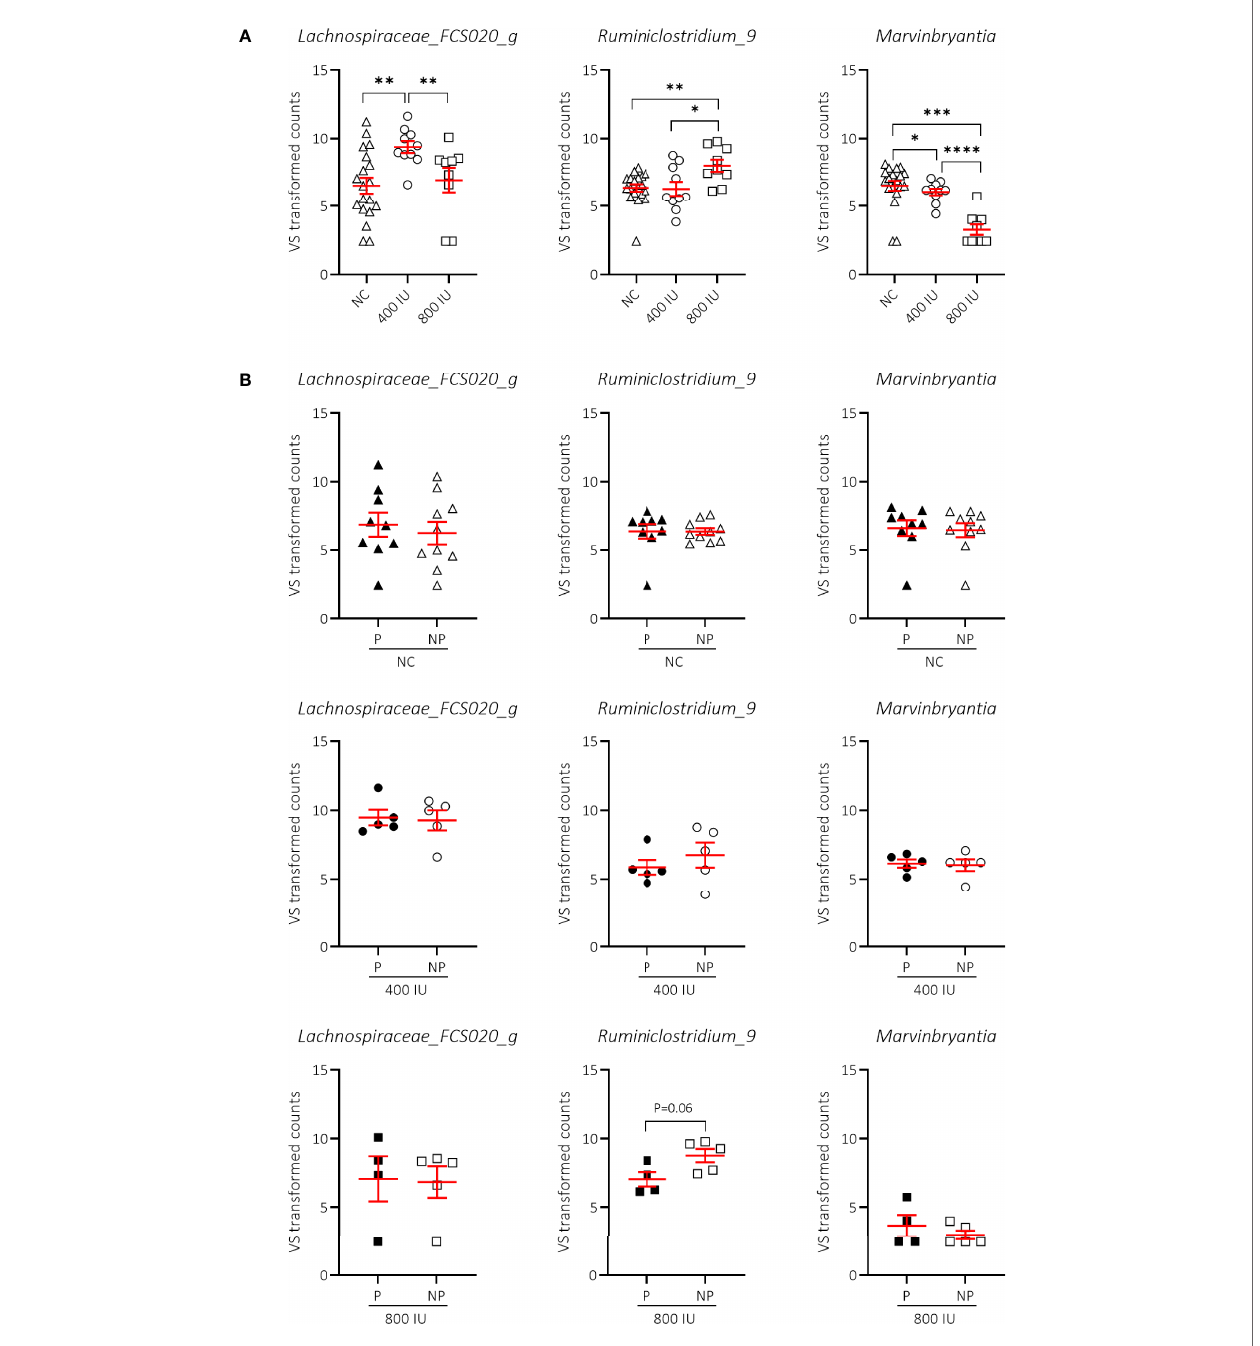
FIGURE 8 | Difference in genera abundances between diets and T1D subgroups at 8 weeks of age. Differences in genera abundances between diets at 8 weeks of age are shown for female NOD mice receiving normal chow (NC), 400 or 800 IU/day vitamin D-supplemented diets (A) . Differences in genera abundance for the corresponding diets shown in (A) are separated based on disease outcome (B) . P = progressor mice, NP = non-progressor mice. Symbols (N = 4-19) represent individual mice, and the line re fl ects the group mean with SEM. *P ≤ 0.05; **P ≤ 0.01; ***P ≤ 0.001; ****P ≤